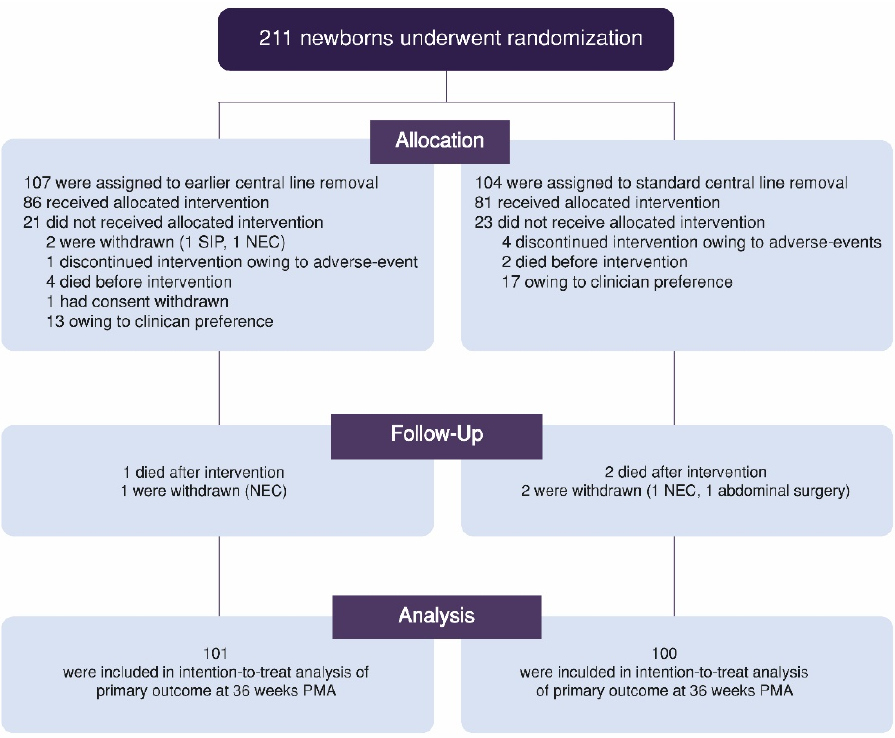
Figure 1. Consolidated Standard of Reporting Trial flow diagram. Abbreviations: PMA, postmen- strual age; SIP, spontaneous intestinal perforation; NEC, necrotizing enterocolitis.